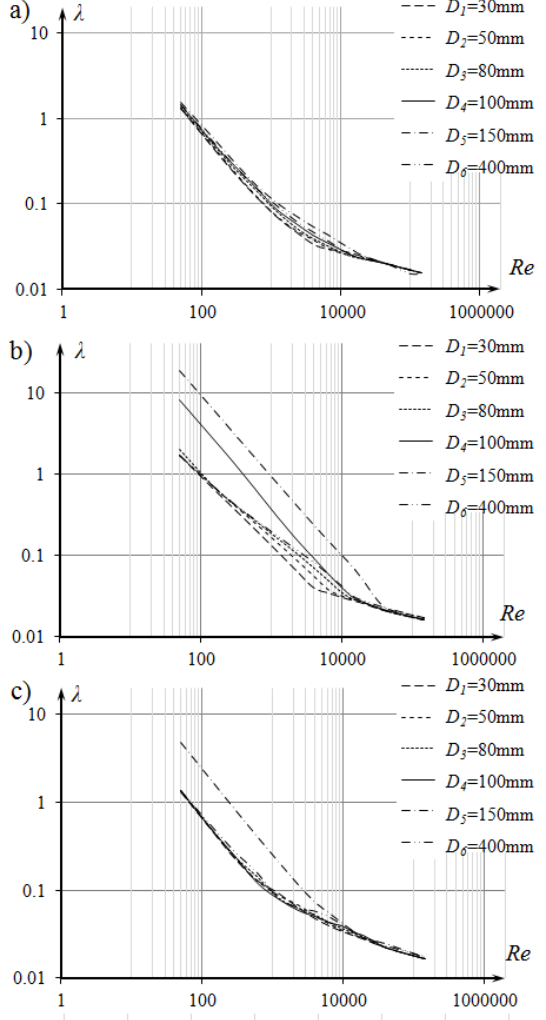
Fig. 3 Dependence between major loss coefficient λ and Reynolds number Re for a) Spalart- Allamars turbulence model, b) k- ε turbulence model, c) k- ω turbulence model Simulation was made for six different diameter D ( D 1 =30, D 2 =50, D 3 =80, D 4 =100, D 5 =150, D 6 =400, mm) and fourteen different Reynolds number ( Re = 50, 150, 300, 600, 1 200, 2 300, 4 000, 6 500, 10 4 , 1.45·10 4